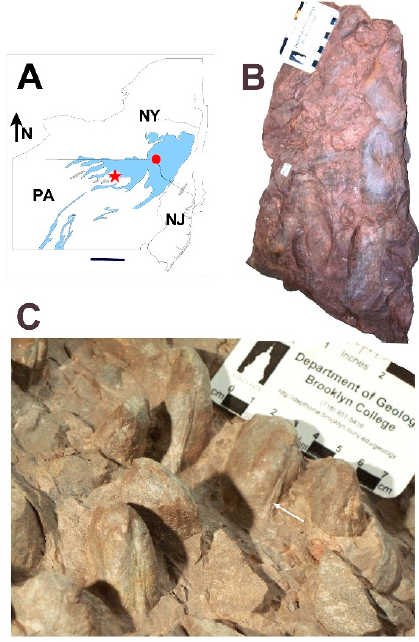
Figure 1. Preservation styles of Archanodon catskillensis . ( A ) Map of New York State (NY), Pennsylvania (PA), and New Jersey (NJ) showing collection locality of the Paleontological Research Institute (PRI) specimen illustrated in B (red dot), and the Academy of Natural Sciences of Drexel University (ANDU) specimen illustrated in C (red star), respectively. Blue shading shows the outcrop area of terrestrial Catskill facies of Johnson and Friedman [30]. Scale bar = 100 km; ( B ) Siltstone slab showing post-mortem transported accumulation of A. catskillensis. All are internal molds; Downsville Arch, Downsville, Delaware County, NY; PRI, Trumansburg, NY, specimen #94-03-10. Scale divisions = 1 cm; ( C ) Siltstone slab showing A. catskillensis shell impressions in original life position steeply inclined to bedding. Shell casts have a subparallel orientation, most with hinge facing the camera. White arrow points to the hinge claustrum in specimen below the scale bar. Other specimens can also be seen to have a claustrum within their hinge lines. Specimen comes from the Catskill Formation exposed in a road cut, US Highway 15, near Powys, Lycoming County, PA. Slab is an unnumbered specimen held in the fossil collection of ANDU, Philadelphia, PA. Scale divisions = 1 cm.